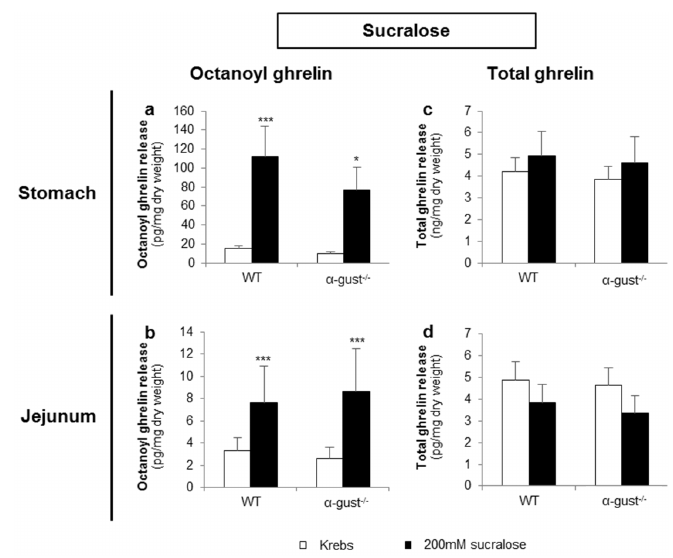
Figure 5. Sucralose increased octanoyl ghrelin, but not total ghrelin release from gastric and jejunal segments in an α‐ gustducin ‐ independent manner. Effect of 2 ‐ h stimulation with 200 mM sucralose or Krebs buffer on ( a , b ) octanoyl and ( c , d ) total ghrelin release from tissue segments of the corpus of the stomach ( n = 6) or the jejunum ( n = 6) from WT) and α‐ gust − / − mice. Results are presented as predicted values ± standard error of the predicted values. * p < 0.05, *** p < 0.001 vs. Krebs treated segments. Nutrients 2016 , 8 , 795